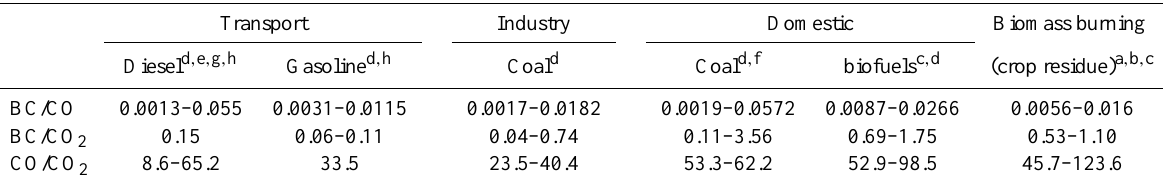
Table 6. BC/CO (µgCm − 3 /ppbv), BC/CO 2 (µgCm − 3 /ppmv), and CO/CO 2 (ppbv/ppmv) emission ratios derived from emission factors (grams of pollutant evolved per kilogram of fuel